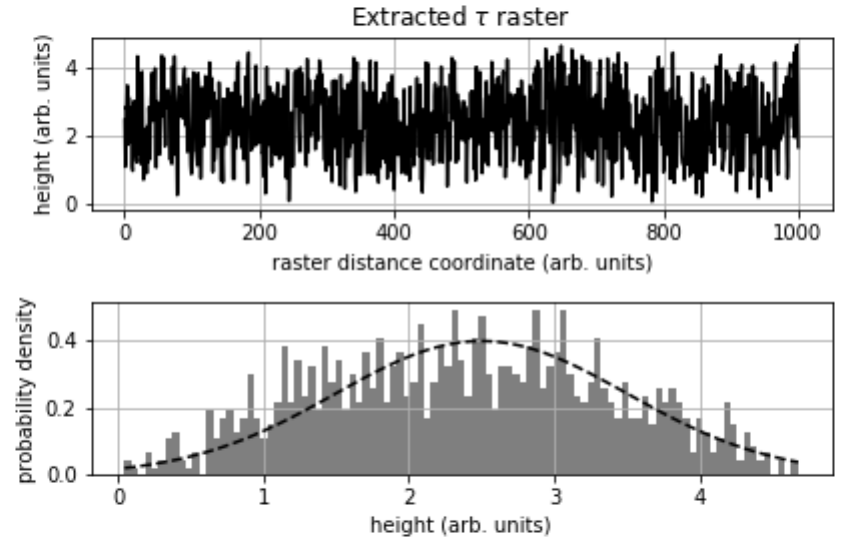
Figure 6. The DSM noise-object field N ( 2.5,1.0 ) and its extraction from the original Gaussian hill profile terrain data along the principle diagonal τ ( x , x − 1024 ) (image pixel coordinates). The true probability density function of the signal is shown in dashed black. The recovered object field is therefore mapped back to a noise signal normally distributed about the mean object field height. Around 99% of the probability mass is successfully segmented in this